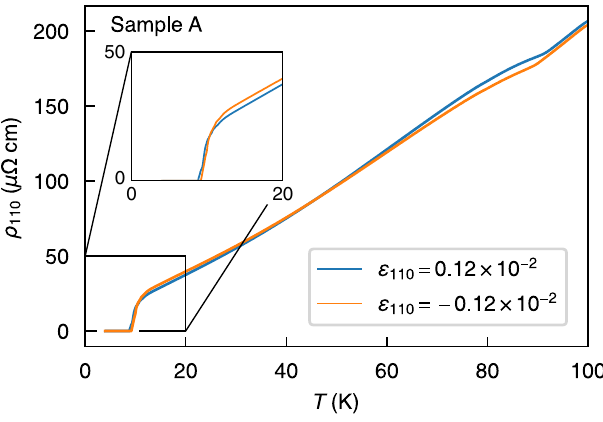
FIG. 12. ρ 110 versus T of sample A over a wide temperature range.